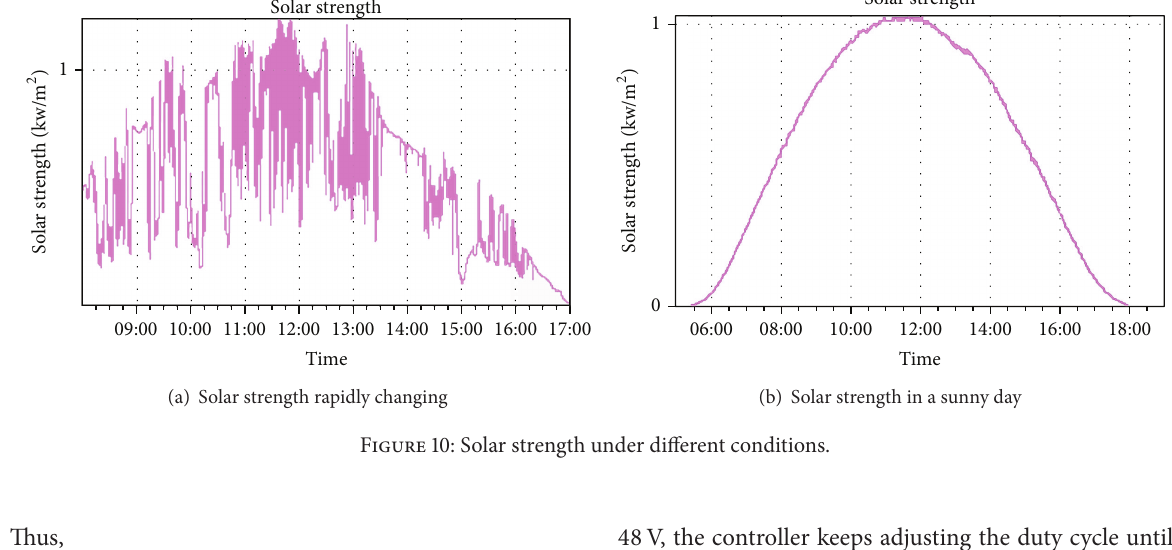
Figure 10: Solar strength under different